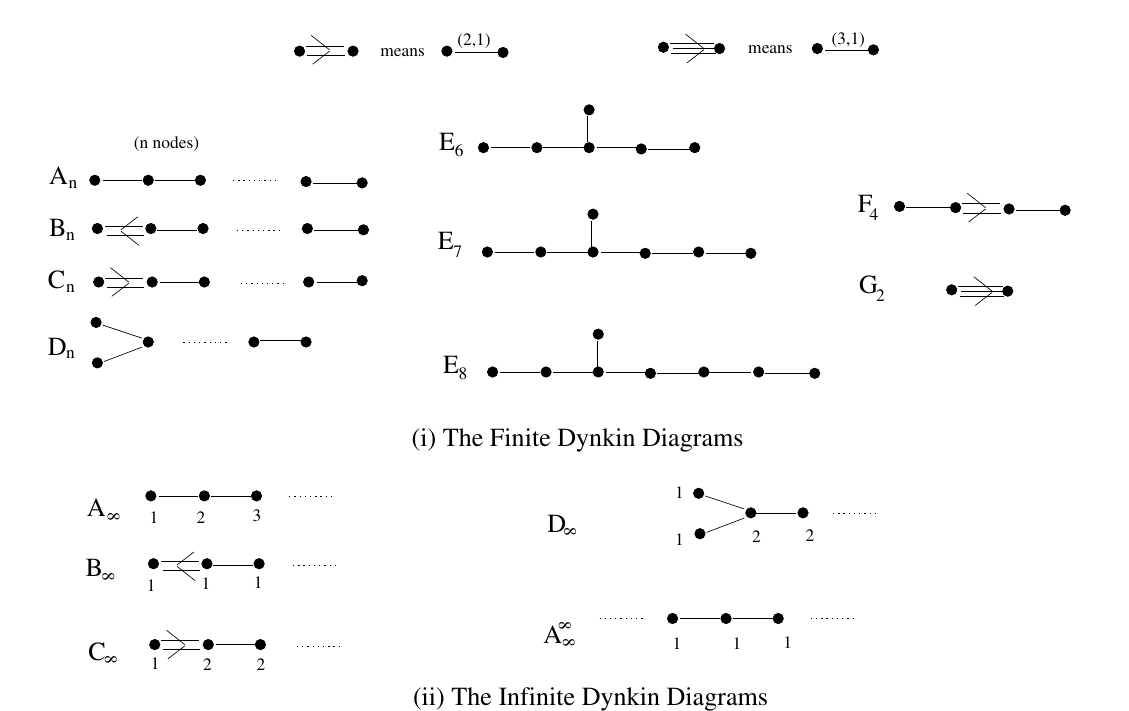
Figure 2. The Finite and Infinite Dynkin Diagrams as labeled quivers. The finite cases are the well-known Dynkin–Coxeter graphs in Lie Algebras (from Chapter 4 of [31]).